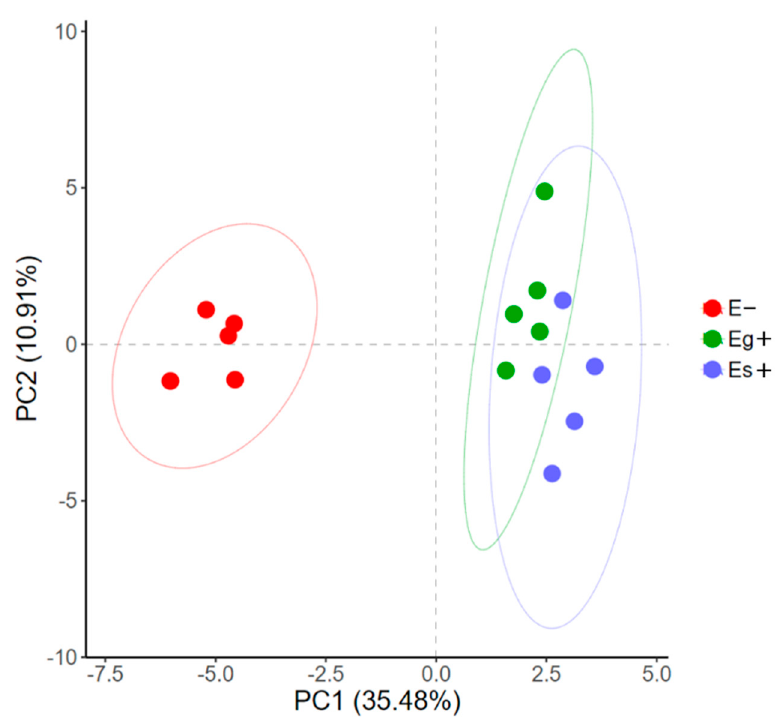
Figure 3. PCA of metabolites in Achnatherum sibiricum infected with Epichloë gansuensis (Eg+) and Epichloë sibirica (Es+) and without endophytes (E − ). The symbols refer to samples, and the ellipse defines the 95% confidence region.